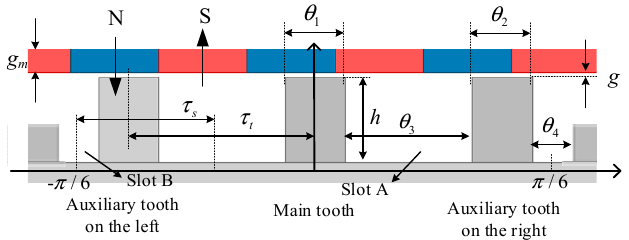
Figure 3. Expanded view of one tooth unit in non-uniform distribution. Table 1. Machine parameters and constraints.